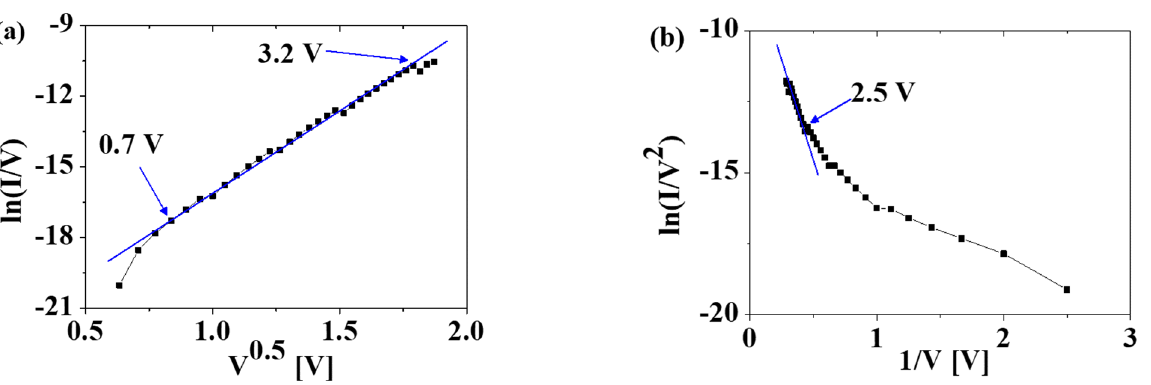
Figure 3. ( a ) Logarithmic scale of current density as a function of voltage in the MFM capacitor. ( b ) Normalized current power spectral density ( S I / I 2 ) versus frequency as a function of bias voltage ranging from 0.7 to 3.4 V.